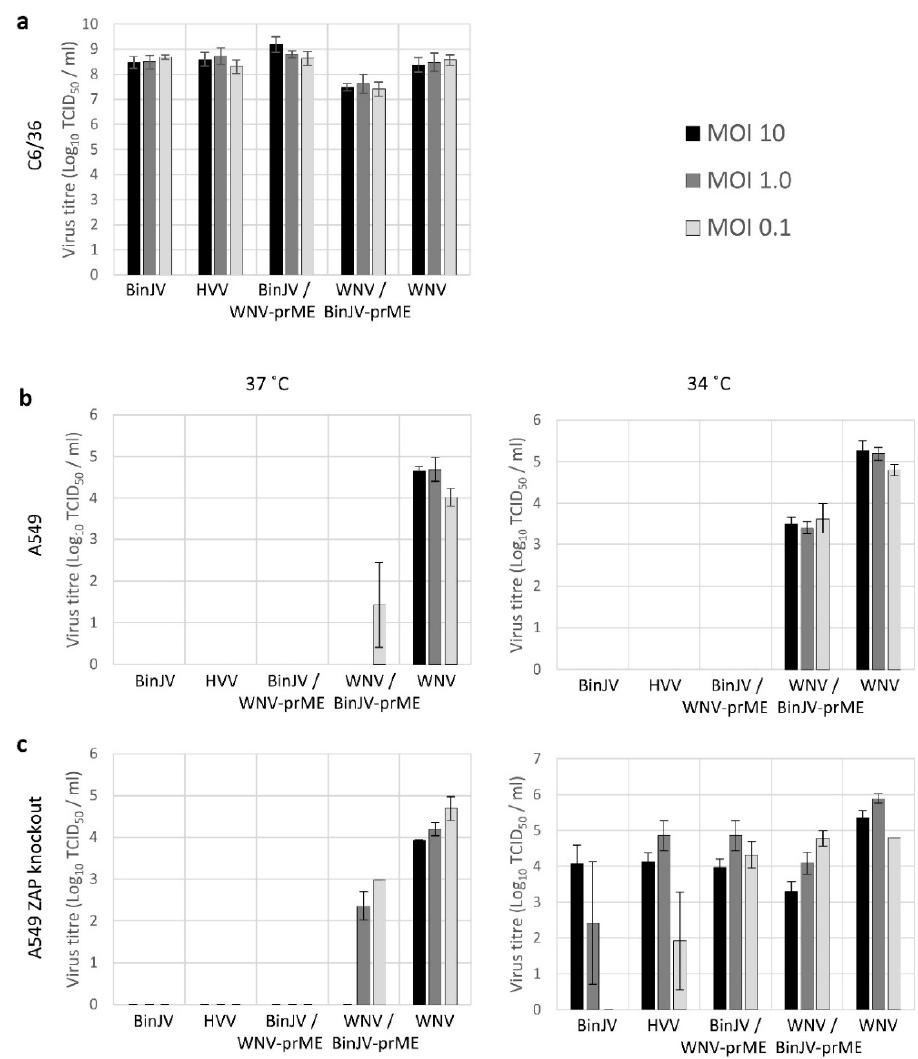
Figure 6. Lineage II ISF replication in human cells is regulated by ZAP and temperature at multiple stages of infection. C6/36 mosquito cells ( a ), human A549 cells ( b ), or A549 ZAP knockout cells ( c ) were infected with three different multiplicity of infections (MOI). After five days of incubation at the indicated temperatures infectious virus titres in the cell culture supernatant was measured. Bars represent average values of triplicate samples from the indicated MOI infection and error bars one standard deviation of the mean.